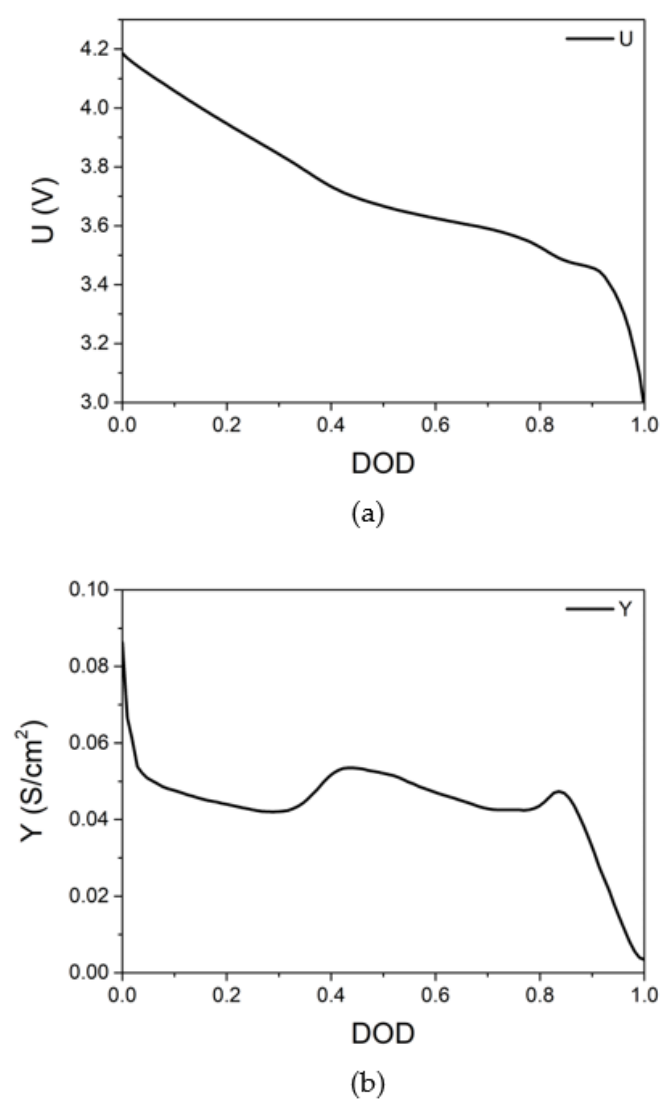
Figure 5. Fitting parameters of 1st LIB strand to calculate voltage behavior ( a ) U and ( b ) Y.